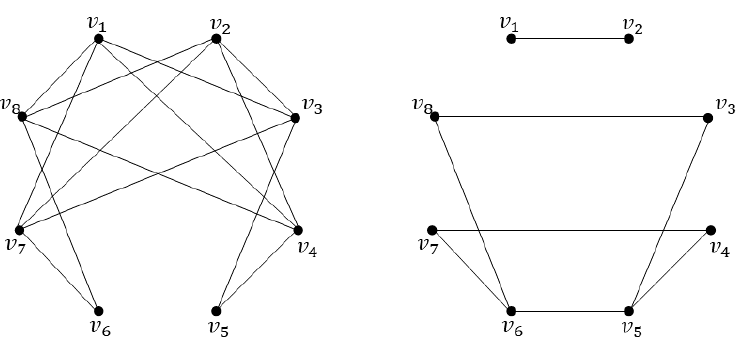
Figure 5. The graph D and its δ -complement D δ